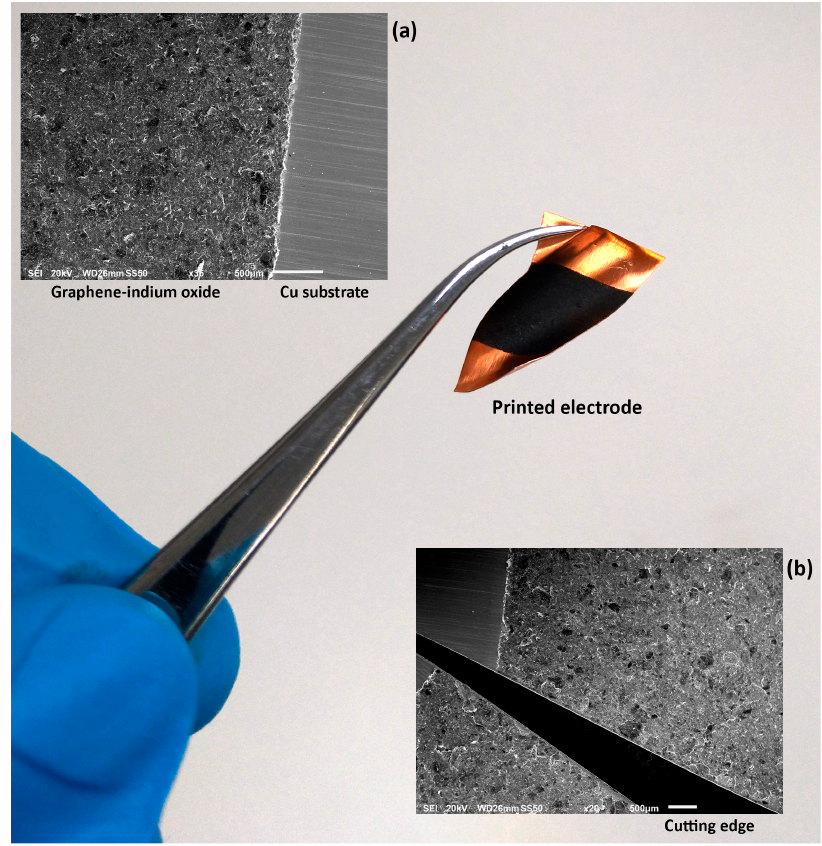
Figure 5. Surface of the printed electrode. before ( a ) and after ( b ) applying multiple mechanical tensions including bending and cutting. Both SEM scale bars are 500 µm.